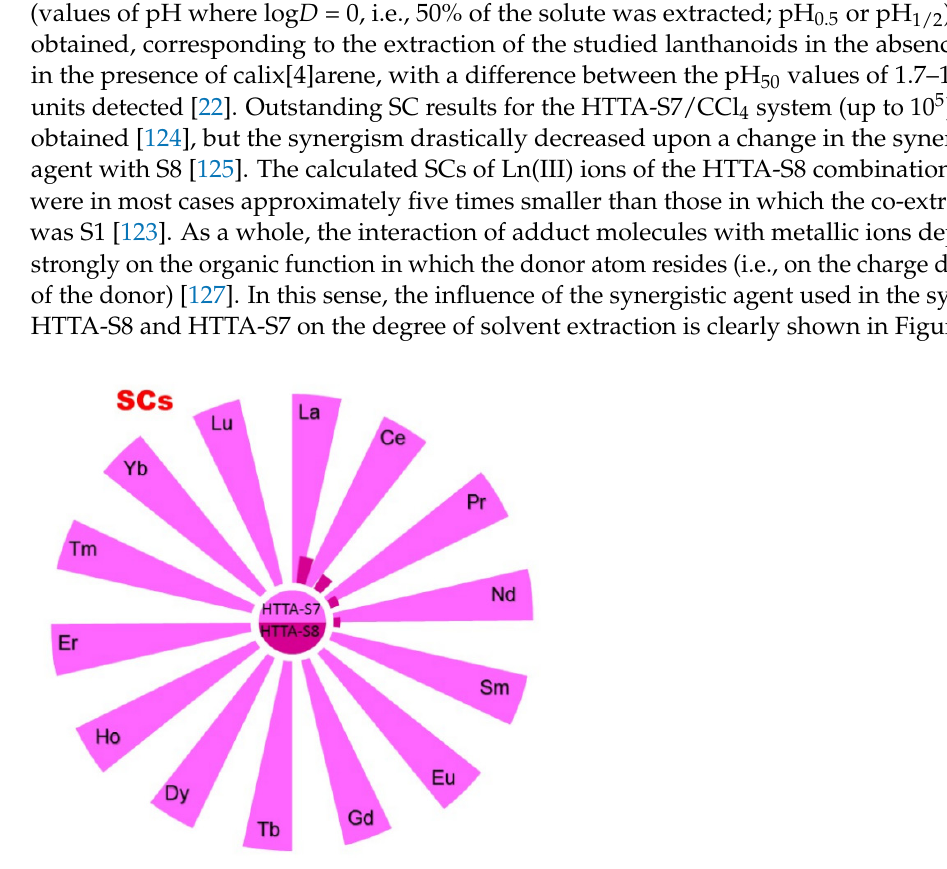
Figure 10. Comparison of synergistic solvent extraction systems for lanthanoids: log K T,S vs. Z. Table 4. Recommended data for the synergistic system of thenoyltrifluoroacetone and organophosphorus ligands when different temperatures were applied. Cation